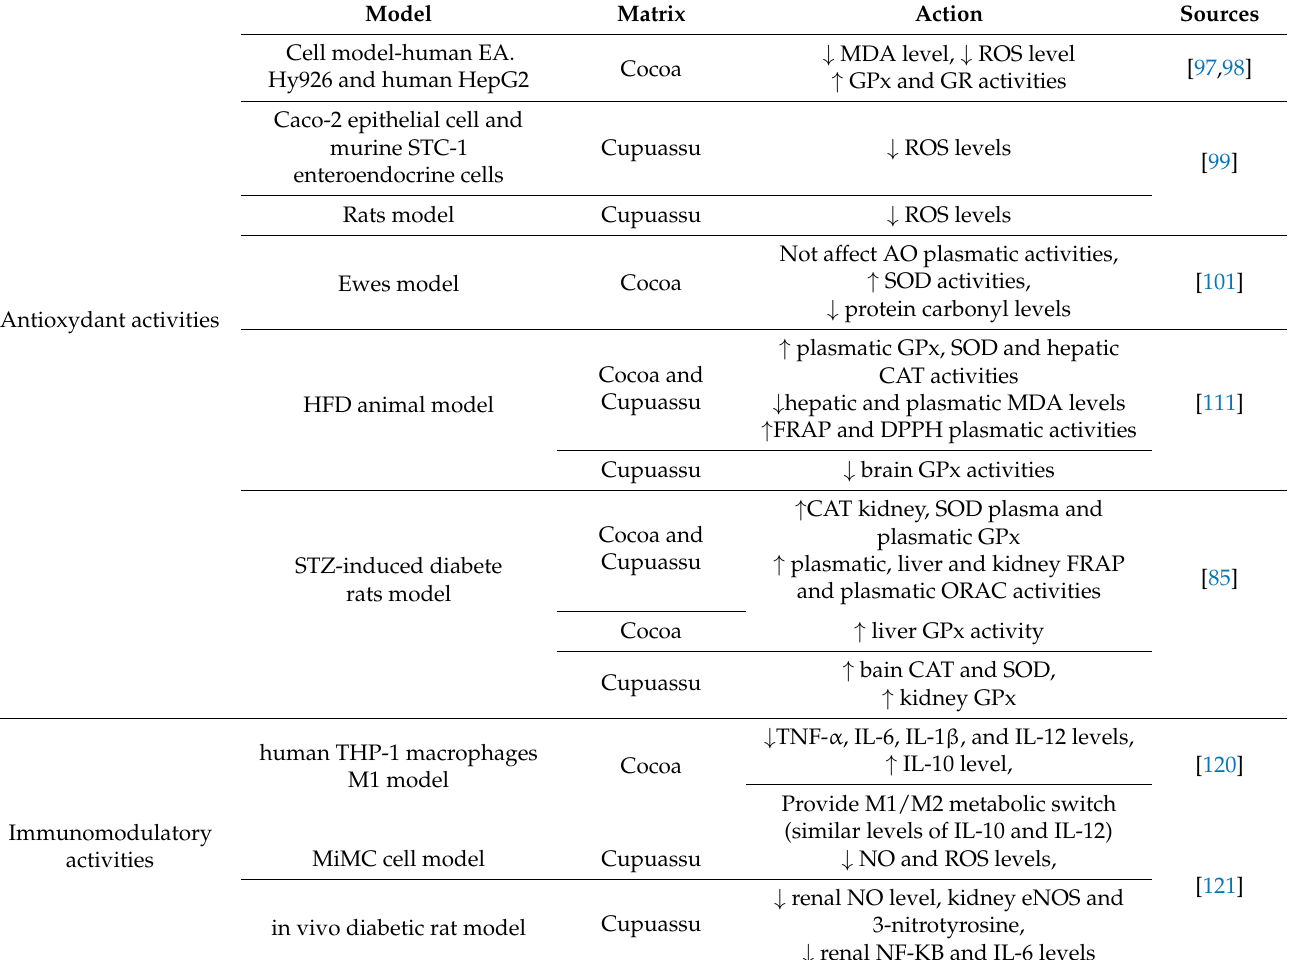
Table 3. Summary of pharmacological activities of cocoa and